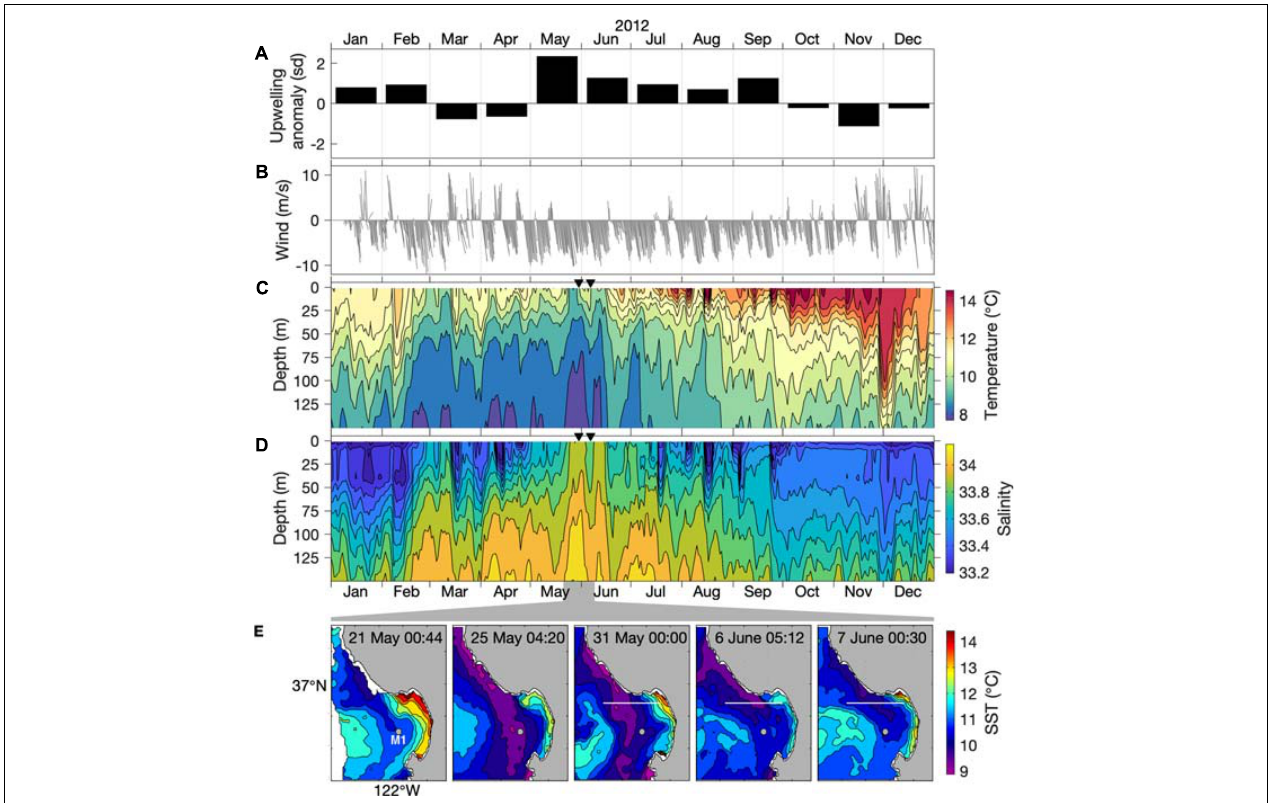
FIGURE 2 | Regional upwelling conditions. (A) Monthly anomaly of the upwelling index at 36 ◦ N, 122 ◦ W (m 3 per second per 100 m of coastline) for 2012, represented as standard deviations (sd) relative to a long-term (20-year) monthly climatology. (B) Wind speed from NDBC Station 46042 (location in Figure 1A ). (C,D) Water-column temperature and salinity at the M1 mooring (location in Figure 1A ). Triangles mark the start of two AUV sampling periods, 30 May (for 30 May through 1 June) and 6 June (for 6–7 June). (E) Sea surface temperature (SST) variation during 21 May–7 June 2012. Times are UTC. The location of mooring M1 (gray dot) is indicated. The 36 ◦ 54 (cid:48) N AUV transect (white line) is indicated on days when AUV surveys were conducted ( Figure 3